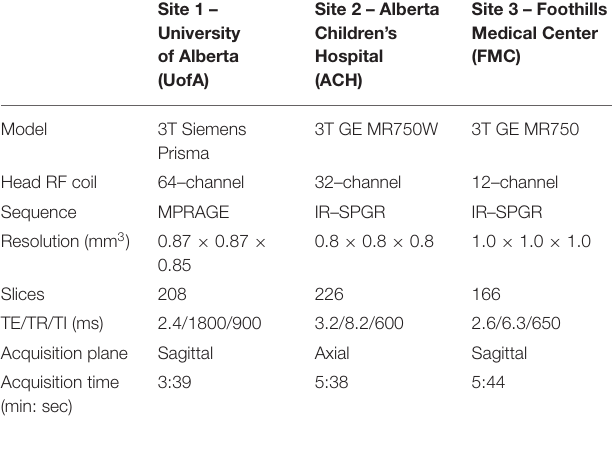
TABLE 2 | Scan protocols (optimized independently at each site).